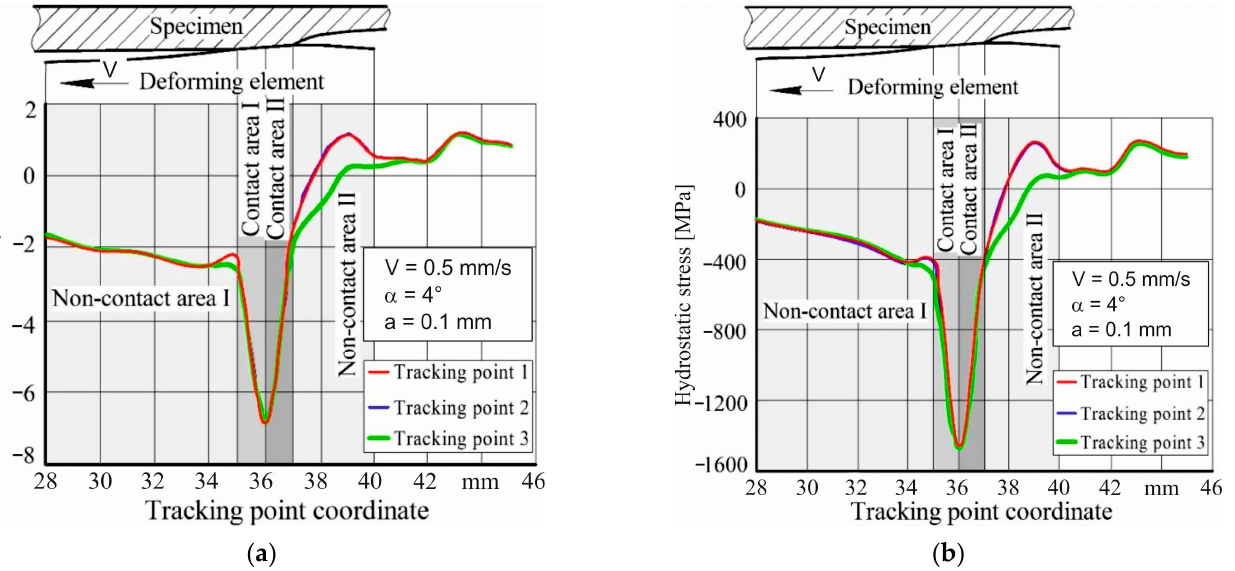
Figure 11. Change in the stress triaxiality ratio η and hydrostatic stress σ along with the tracking point coordinate. ( a ) stress triaxiality ratio, ( b ) hydrostatic stress. point coordinate. ( a ) stress triaxiality ratio, ( b ) hydrostatic